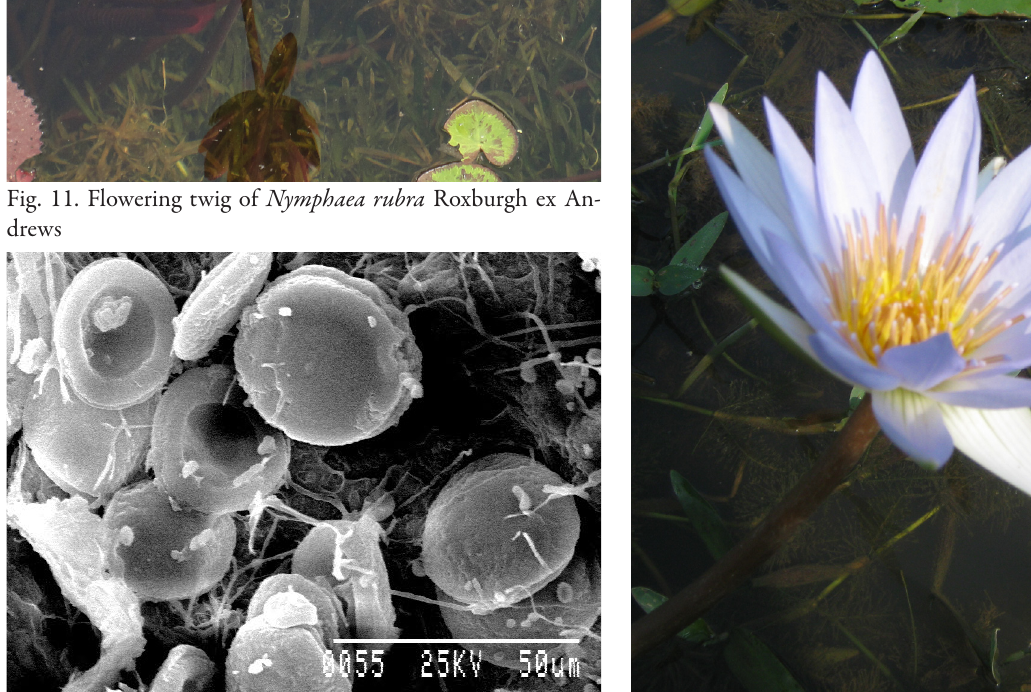
Fig. 12. X3000, monocolpate spheroidal pollens of Nymphaea rubra Roxburgh ex Andrews